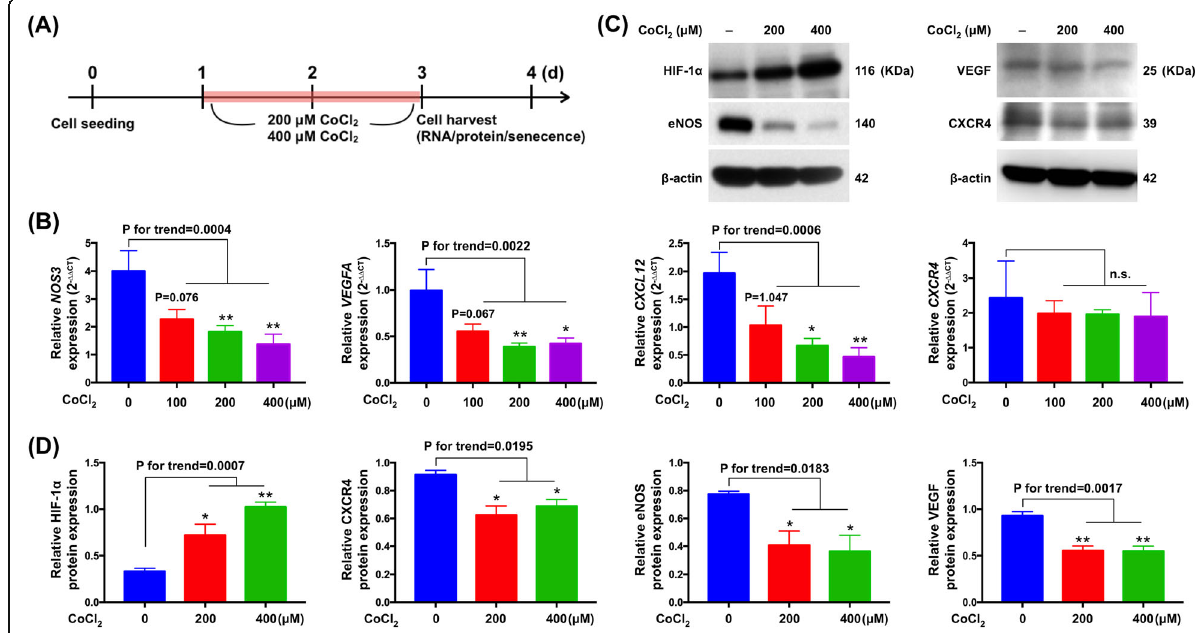
Fig. 1 Cobalt (II) chloride (CoCl 2 ) in rat vascular smooth muscle cells (A7r5) inhibited angiogenesis. a Schematic of the protocol for treatment of A7r5 VSMCs with CoCl 2 or medium only. b mRNA expressions of NOS3, VEGFA, CXCL12 and CXCR4 compared in cells treated with CoCl 2 or medium only ( n = 3). c Representative western blots depicting HIF-1 α , eNOS, VEGF and CXCR4 expression in CoCl 2 and medium treated cells. d Normalized expressions of HIF-1 α , eNOS, VEGF and CXCR4 ( n = 3). Data are presented as the means ± SEM of three independent experiments performed by triplicate, * P < 0.05; ** P < 0.01; ns, non-significance (one-way ANOVA with Tukey-Kramer post hoc